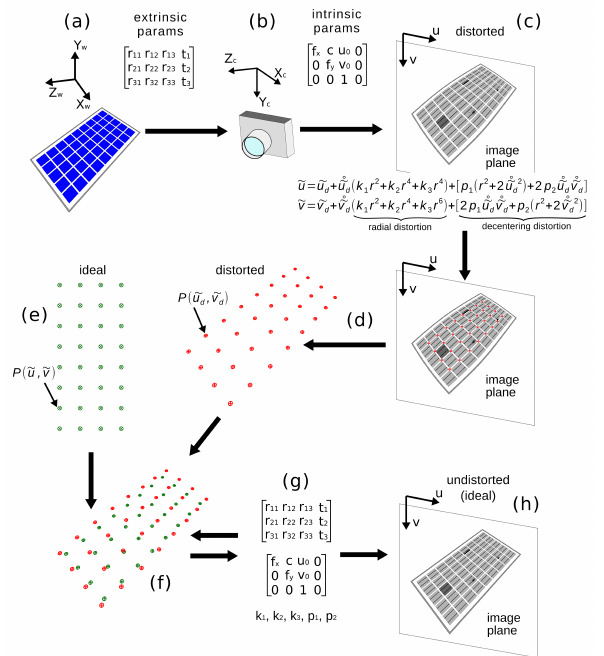
Figure 1. Automated camera calibration procedure acc. to Bedrich et al. [12]: ( a ) Device under test (DUT) in 3D world coordinates. ( b ) The extrinsic camera parameters describe the transfer from 3D world coordinate system to 3D camera coordinate system. ( c ) The intrinsic camera parameters describe the transfer from 3D camera coordinate system to 2D image coordinates. The lens distortion model of Brown [17] is assumed, which is described by the unknown coefficients k 1 , k 2 , k 3 , p 1 , p 2 . A distorted image point P ( ˜ u d , ˜ v d ) corrected with the distortion coefficients leads to a distortion corrected point P ( ˜ u , ˜ v ) . ( d ) Pattern detection of the distorted cell gap joints (CGJ) grid. Our pattern detection process is described in Figure 2. ( e ) The assumed distortion free CGJ pattern is used as target pattern. ( f ) Camera parameter and distortion coefficient estimation based on the algorithm of Zhang et al. [9] and Heikkilä et al. [10]. The method estimates the homography between the detected distorted CGJ and target CGJ. ( g ) The extrinsic parameters, intrinsic parameters and the distortion coefficients are adjusted with a non-linear optimization until the predefined abort criterion is achieved. ( h ) The estimated parameters allow the undistortion of the original distorted input